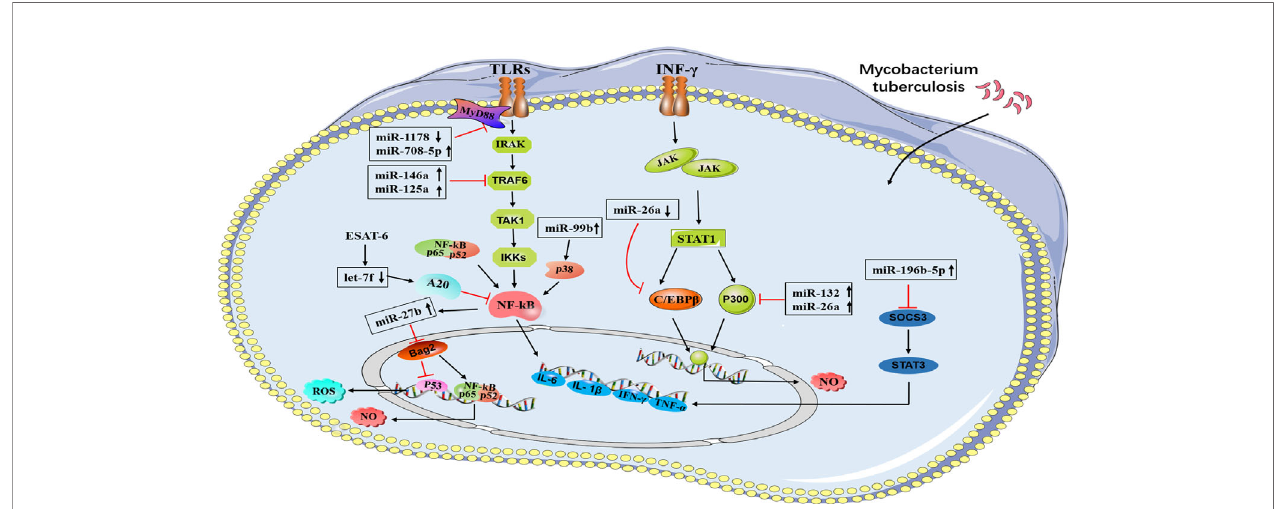
FIGURE 1 | A brief summary of miRNA regulation of signaling pathways during M. tuberculosis infection. A schematic diagram represents different miRNAs and their target genes. MiR-708-5p and miR-1178 negatively regulates the level of TLR4 in macrophages. MiR-27b are induced by TLR2/MyD88/NF- k B pathway. MiR-125a and miR146a negatively regulate the NF- k B pathway by directly targeting TRAF6. MiR-132 and miR-26a down-regulate the transcriptional coactivator p300 (a molecule involved in IFN- g signaling), miR-Let-7f targets A20, a feedback inhibitor of the NF- k B pathway. MiR-99b inhibit the activation of NF- k B, miR-196b-5p activate STAT3 signaling pathway via targeting negative regulators SOCS3. Direct stimulatory modi fi cation; Direct inhibitory modi fi